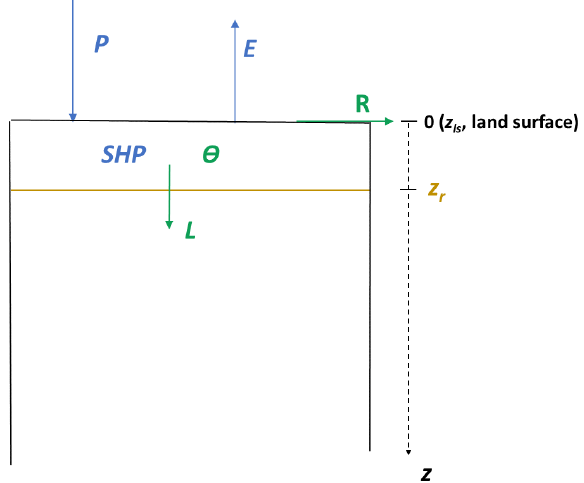
Figure 3. Model conceptualization of the Shallow Subsurface Modelling Framework (SSMF). The fluxes are P , the precipitation at the land surface, E , the evaporation from the soil, R the overland flow and L , the vertical losses through the bottom boundary of z r , the upper zone of the soil. θ is the depth-averaged volumetric water content over z r and SHP stands for Soil Hydraulic Properties over z r . The vertical axis is positively oriented from the surface down the soil profile. The values in blue are the inputs to the SSMF; the values in green are the outputs.